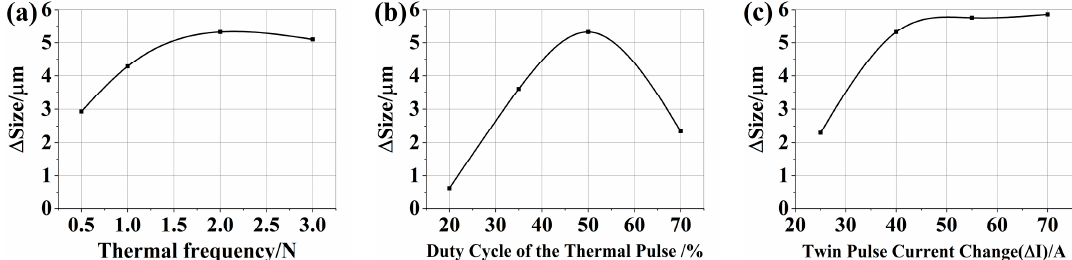
Figure 20. Variation of ∆ Size with ( a ) heat thermal frequency; ( b ) duty cycle of the thermal pulse; ( c ) current amplitude of thermal pulse.